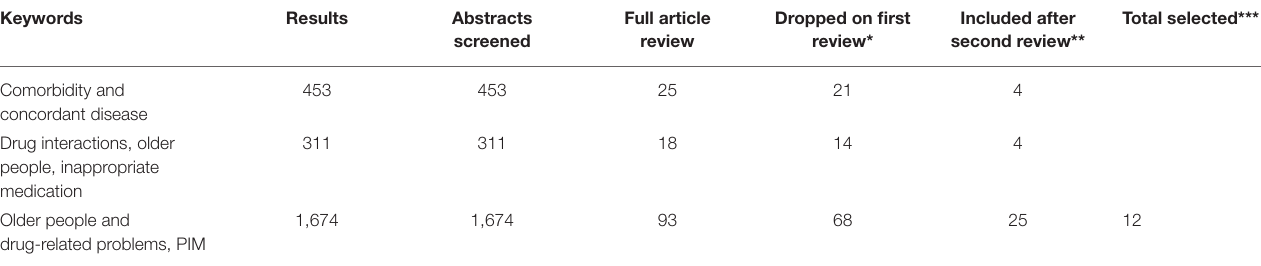
TABLE 1 | Inclusion and exclusion of articles and work